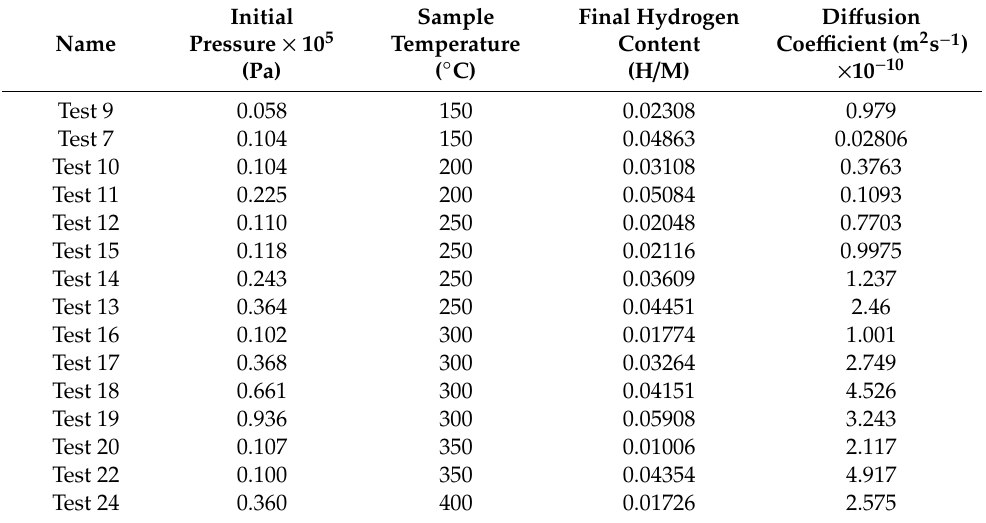
Table 1. Conditions of the absorption kinetics measurements and relative calculated di ff usion coe ffi